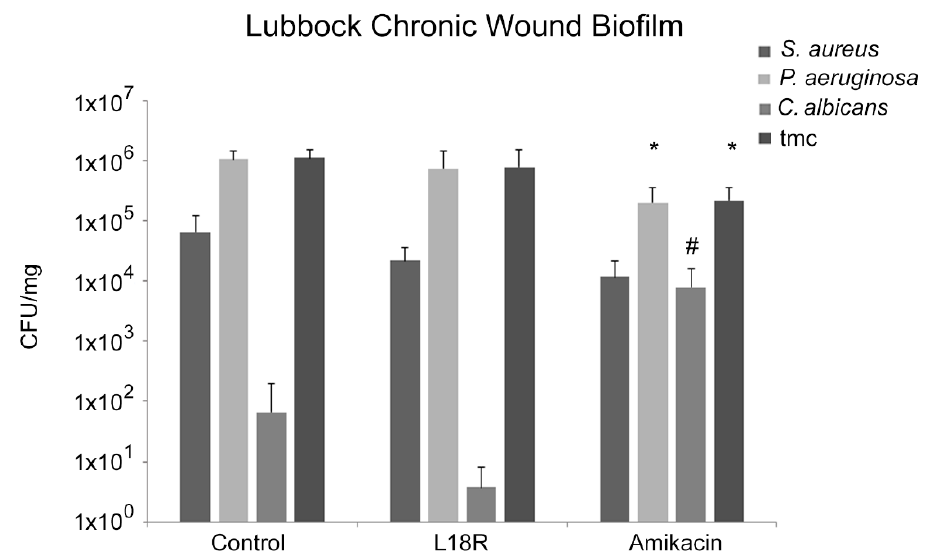
Figure 2. Microbial composition (CFU/mg) of multispecies (MIX 3) in the Lubbock chronic wound mature biofilm after treatment with L18R and amikacin. Black columns represent the total microbial count (tmc). * Statistically significant with respect to the control, # with respect to L18R, ( p < 0.05).